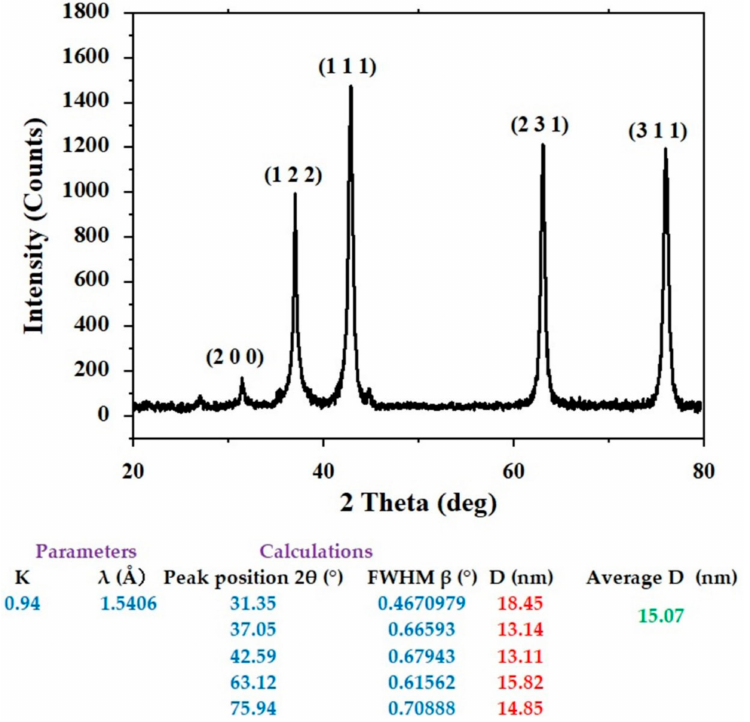
Figure 2. XRD of the biosynthesized